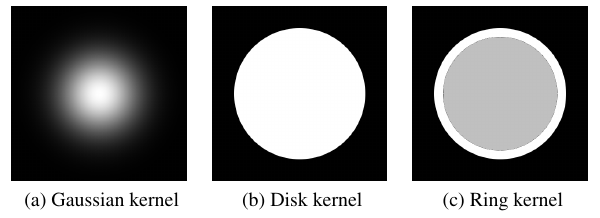
Figure 4. The considered modeled blur kernels.